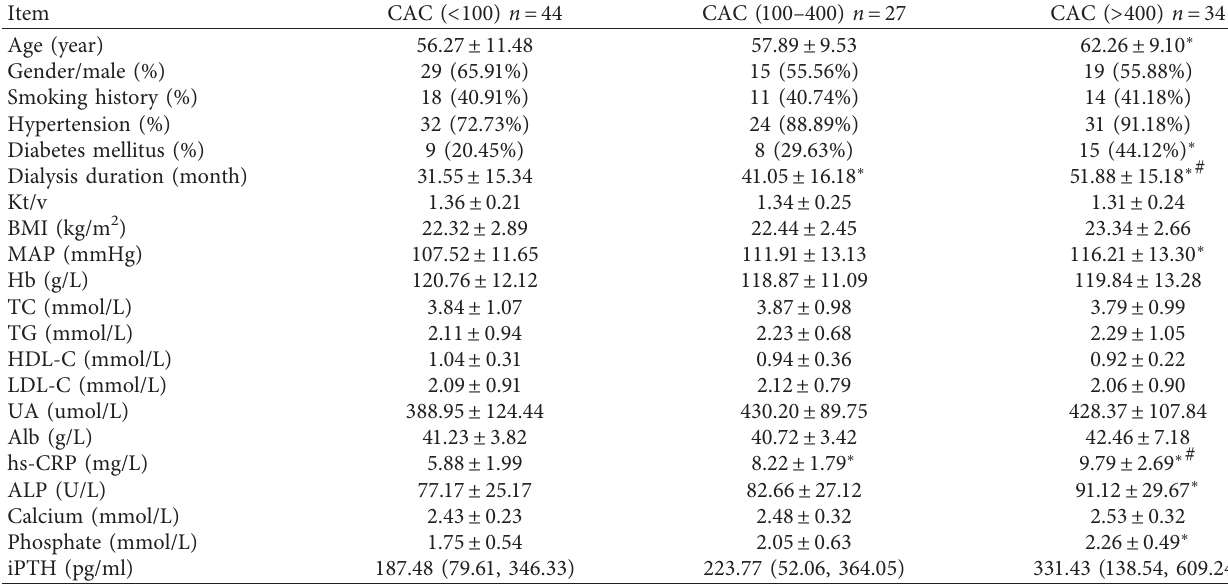
Table 1: Clinical and biochemical characteristics of MHD patients among the CAC ( < 100), CAC (100–400), and CAC ( > 400)